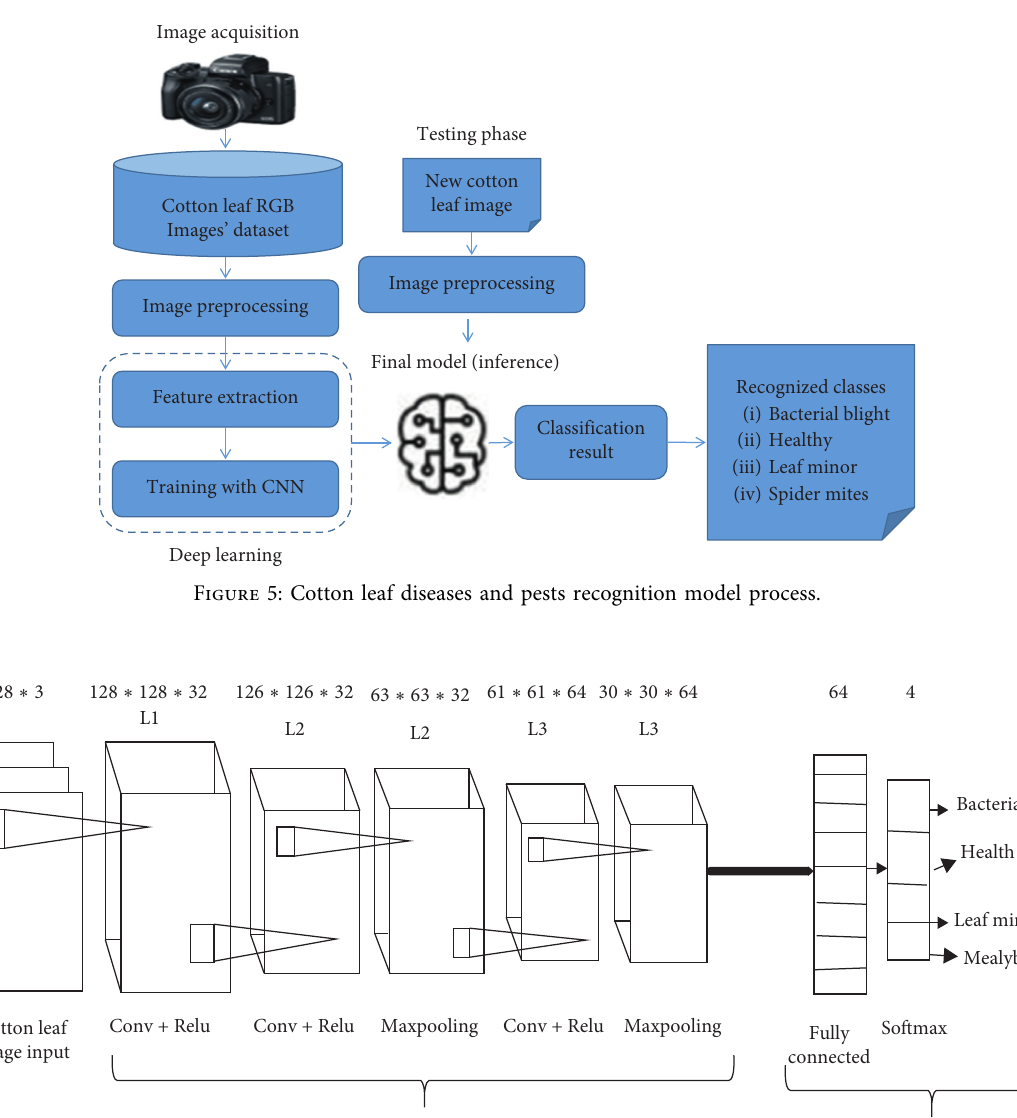
Figure 6: Developed CNN architecture for training.